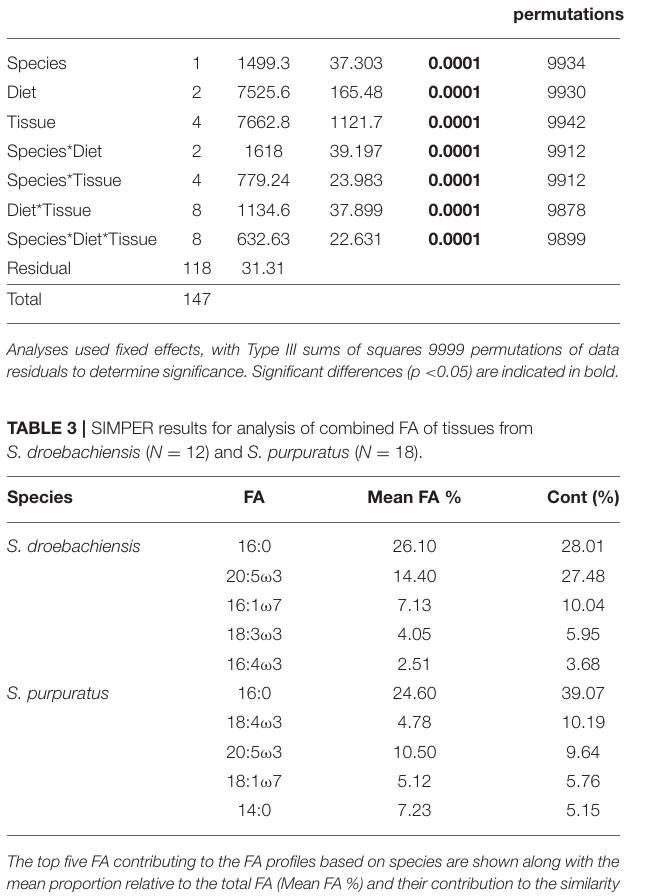
TABLE 2 | Results of PERMANOVA analysis of proportions of identified FA contributing ≥ 1% of identified FA for S. droebachiensis and S. purpuratus (data untransformed, Euclidean distance) in a 3-way design with factors of species, diet, and tissue. Source